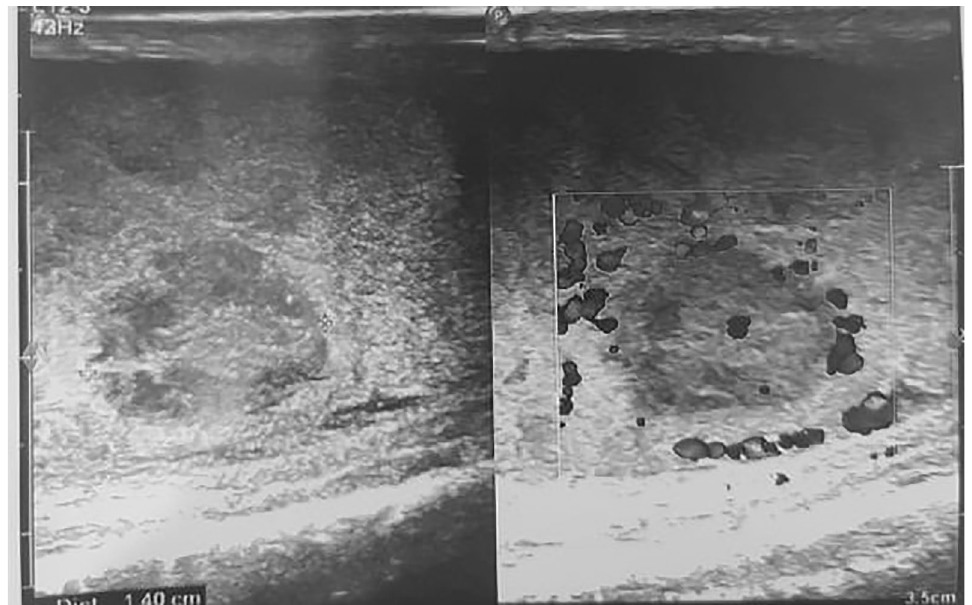
Fig. 1 Ultrasound scan shows ill-defined, hypoechoic lesion with internal